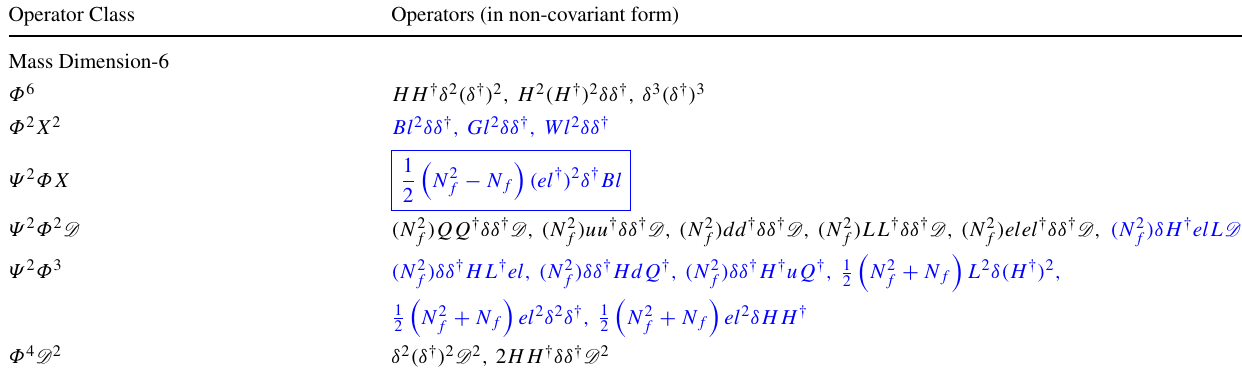
Table 32 SM + doubly charged scalar( δ ++ ): Operators of mass dimension-6 excluding pure SM operators. There are no mass dimension-5 operators except pure SM operators. Here, δ → δ ++ and δ † → δ −− Operator